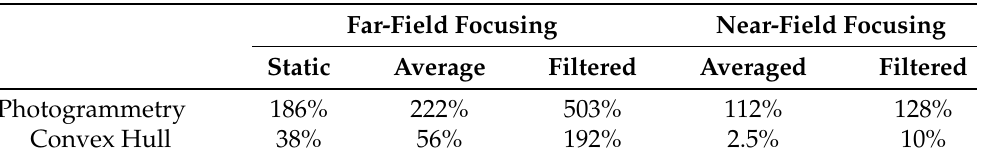
Table 5. Percentage overestimation of the measured grape volume obtained using near-field and far-field focusing compared to the grape volume obtained using photogrammetry 3D scan (580 mL) and convex hull (1200